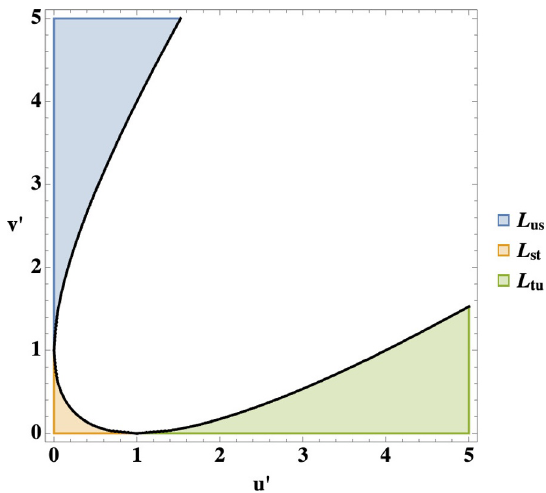
√ √ √ v 0 = u 0 + v | v =1 , L and L . us st tu